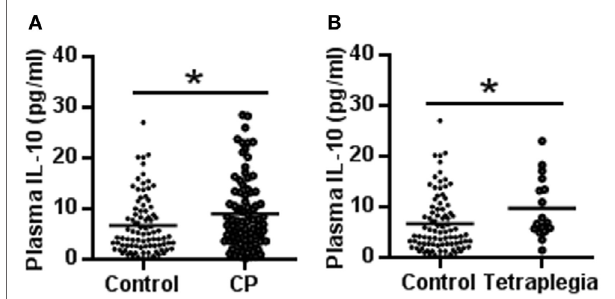
FigUre 1 | IL-10 concentration in cerebral palsy (CP) patients and controls. (a) The scatter plot of plasma IL-10 levels in CP patients and controls. (B) The scatter plot of plasma IL-10 in tetraplegia CP patients and controls (* p < 0.05).